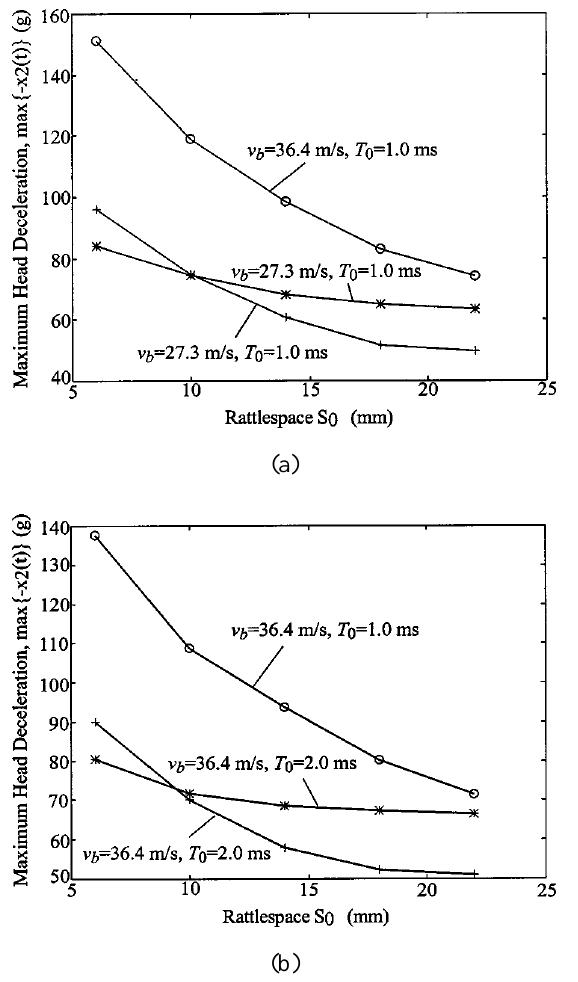
Fig. 13. The trade-off curves for Case 1 (Minimization of peak head acceleration): (a) Front impact: A–P direction, (b) Side impact: L–R